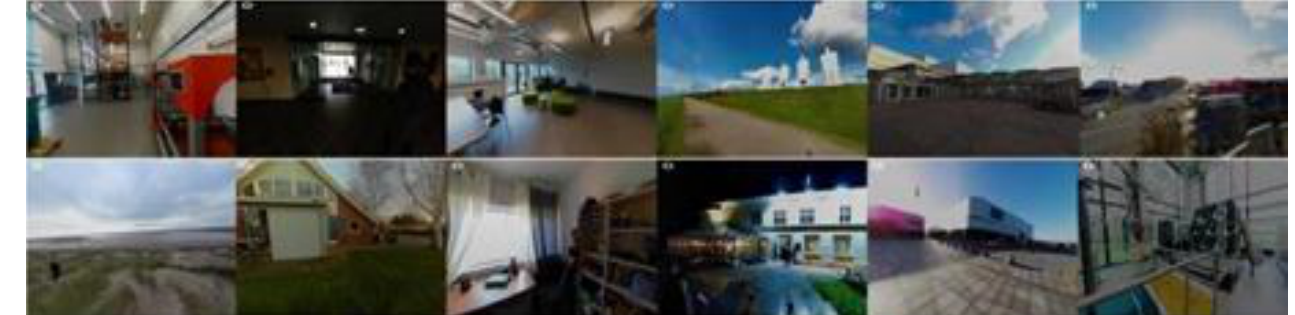
Figure 3. Photo examples of locations available to view in the